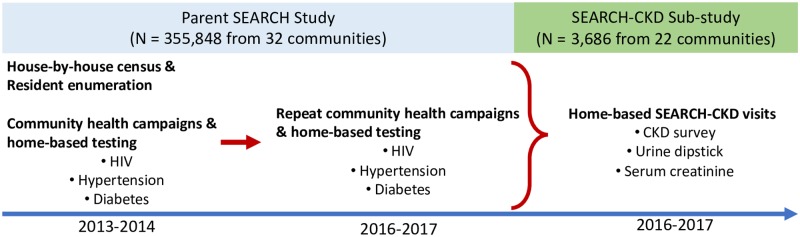
Timeline and study activities for the sustainable East Africa research in Community Health (SEARCH) study sites, and SEARCH-CKD sub-study.